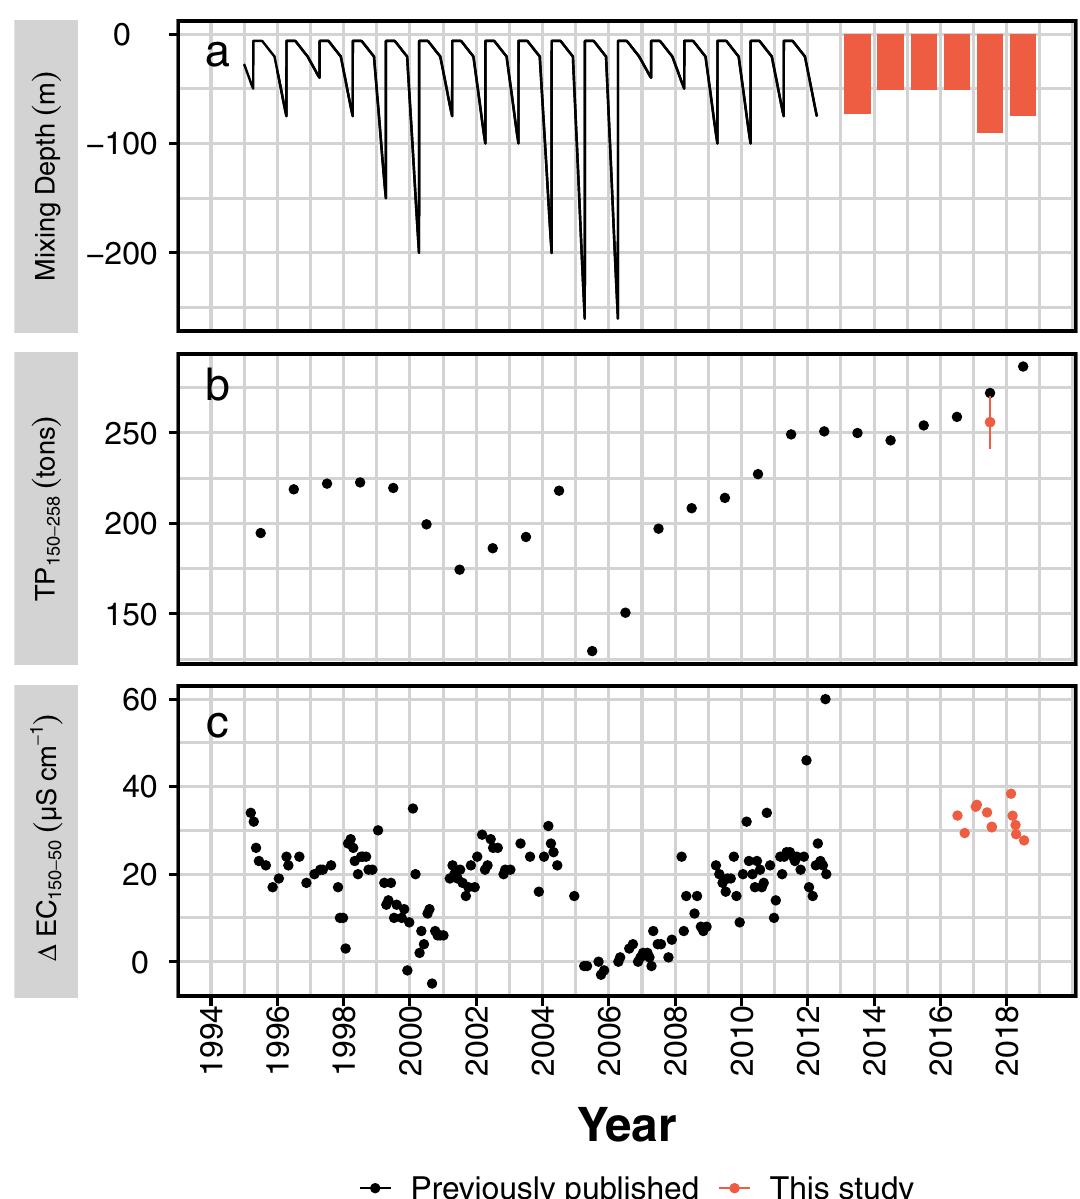
Figure 6. Long term monitoring data from Lake Iseo. ( a ) Mixing depth, shown both as continuous time series until 2012 68 , and as yearly maximum thereafter (M. Pilotti, pers. comm., red bars). ( b ) Total phosphorus in deep waters (150–258 m). Black dots are TP contents (in metric tons) derived from published average TP concentrations 45 . The red bar shows data obtained in this study as range. ( c ) Differences in electrical conductivity (normalized to 25 °C, ΔEC25) between measurements in 150 m and 50 m 47 . Dynamics in ΔEC25 suggest waters from these two depths to experience episodes of decoupling (ΔEC25 increasing), and occasional mixing (ΔEC25 low or zero). Further comparison between EC25 in 50 m and deeper layers can be found in the Supplementary Figure S4. Mixing scenarios are consistent with reports of deep convection in Lake Iseo in 2000, 2005 and 2006 39 , and are accompanied by marked decreases in the deep water TP